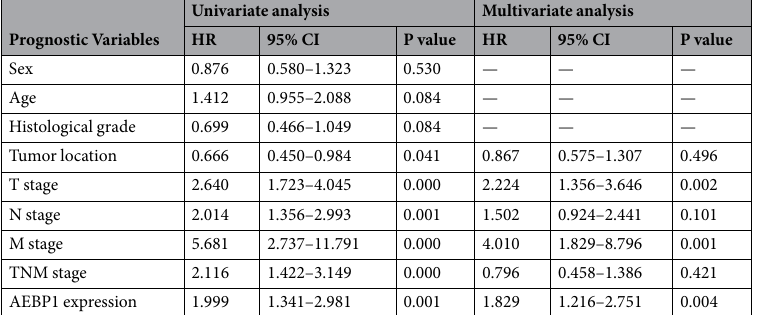
Table 2. Univariate and multivariate analyses of overall survival in patients with gastric